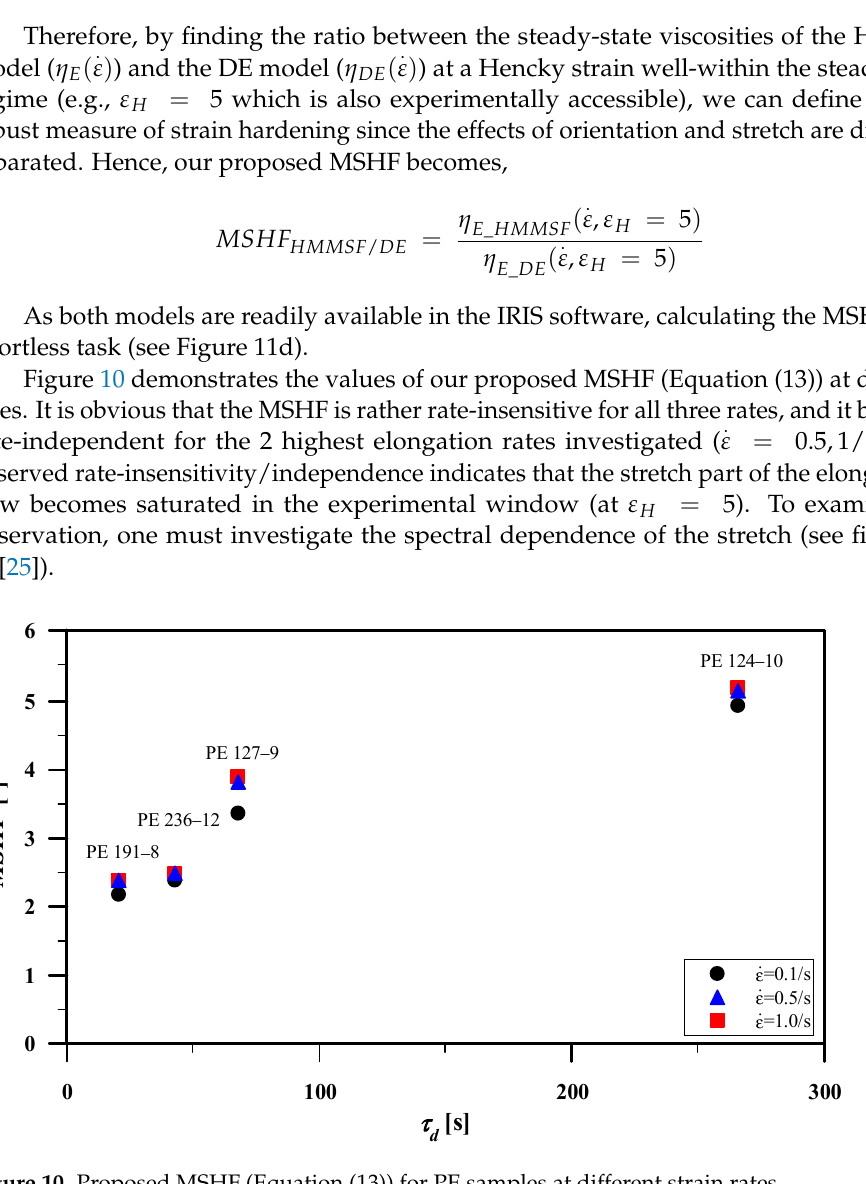
Figure 10. Proposed MSHF (Equation (13)) for PE samples at different strain rates.